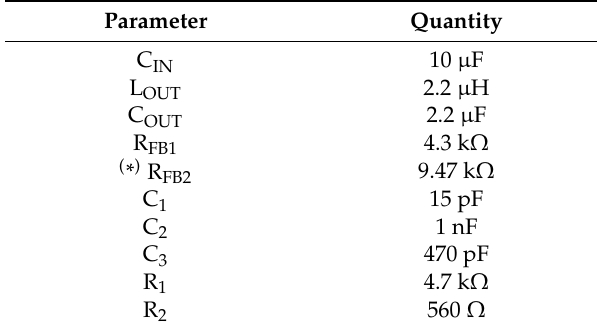
Figure 15. Experimental setup of the monolithic EMI-improved SiP buck converter. R is the current biasing current resistor of the V-I converter for the triangular ramp generator, and the V BR , V HC , and V LC of the triangular ramp generator are easy to tune. Table 2. List of component values used in test setup.